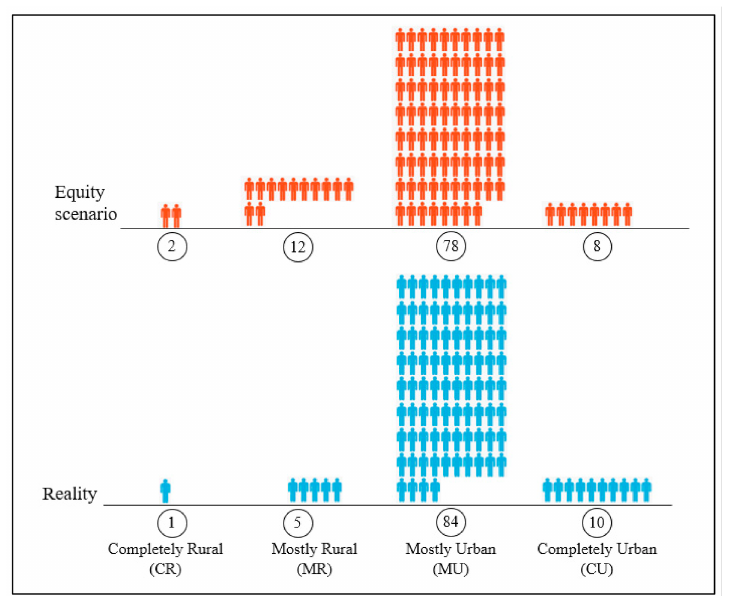
Figure 3. Equity scenario vs. the reality for 100 medical school applicants. Table 1. County-level application and matriculation counts and rate by rurality from 2001 to 2015.